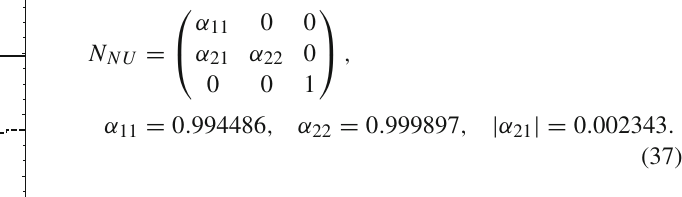
Kamioka, Oki and Korea. In each plot, the blue lines correspond to a neutrino-focusing beam and the red lines correspond to an antineutrino- focusing beam. The solid lines denote ν μ flux and the dashed lines denote ¯ ν μ flux